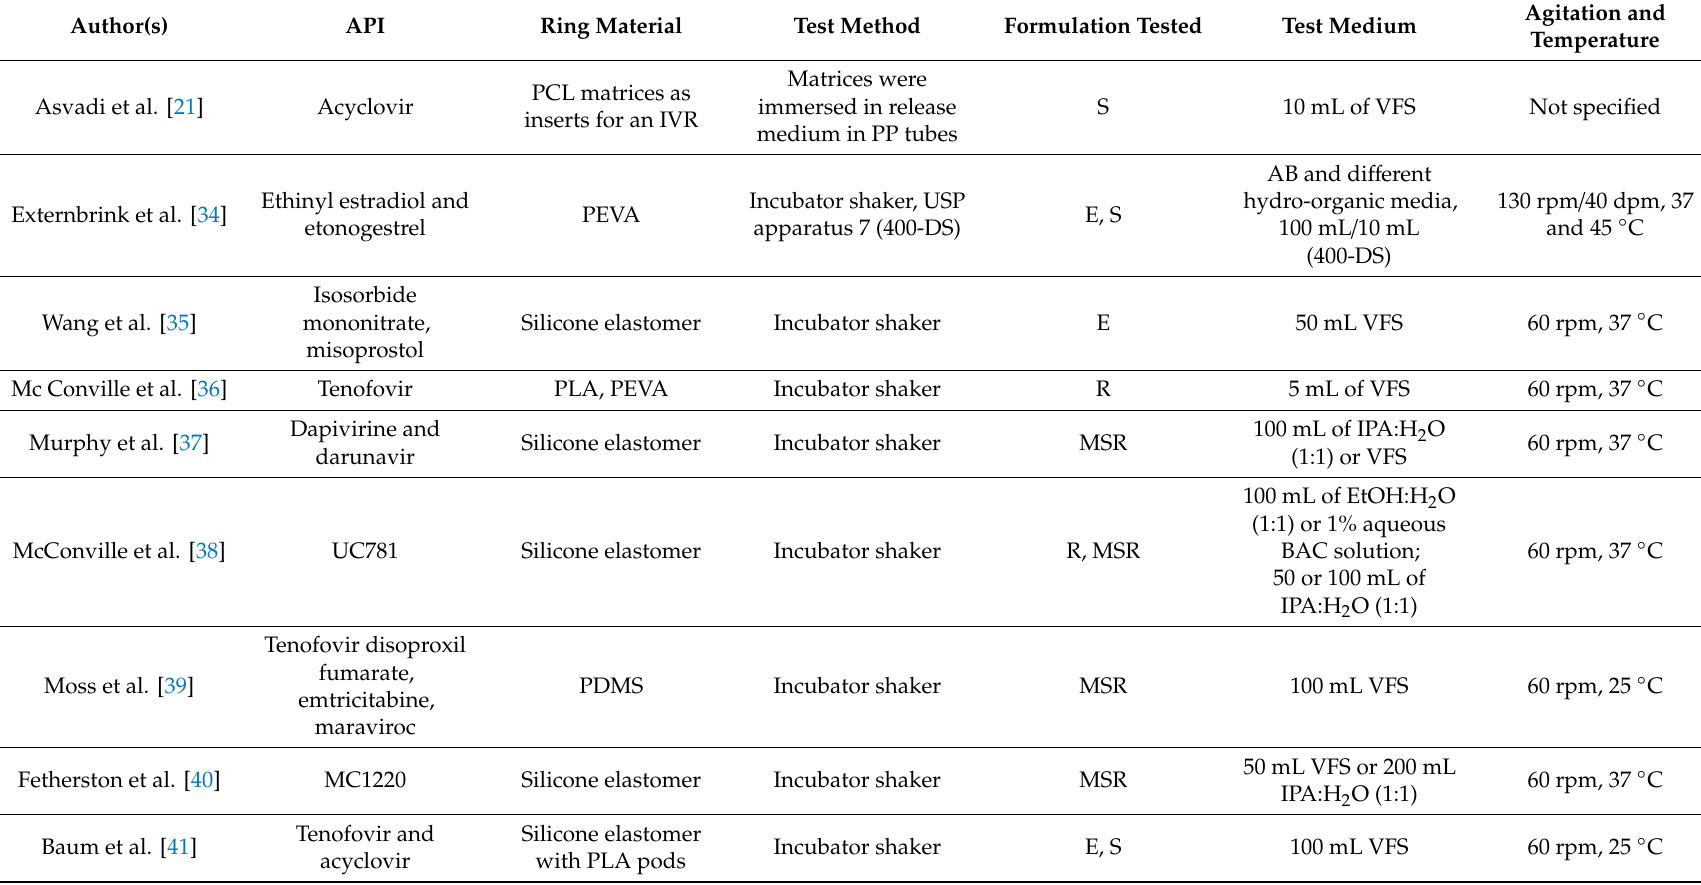
Table 3. Overview of in vitro test methods for release testing of intravaginal rings (IVRs) described in the literature. VFS: vaginal fluid simulant (recipe by Owen and Katz), AB: sodium acetate bu ff er pH 4.2 or 4.5, IPA: isopropanol, EtOH: ethanol, PPB: potassium phosphate bu ff er pH 7.4, E: entire rings were tested, S: segments